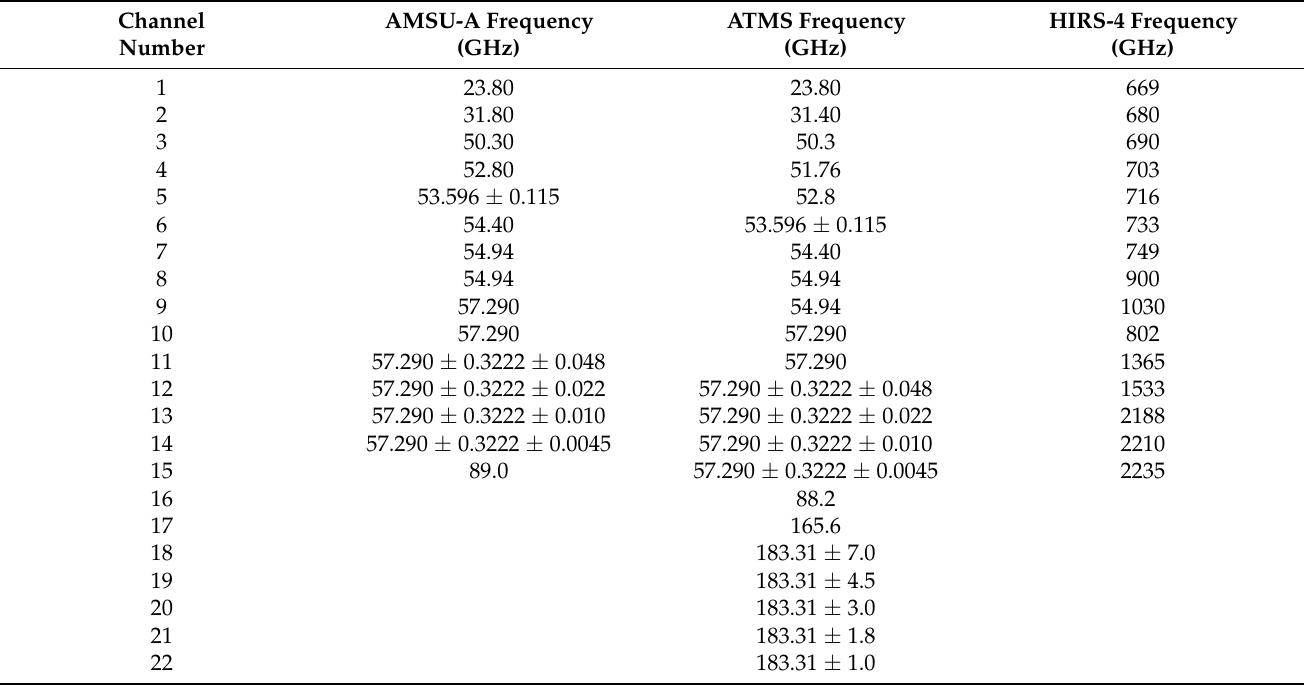
Table 3. AMSU-A, ATMS, and HIRS-4 channel